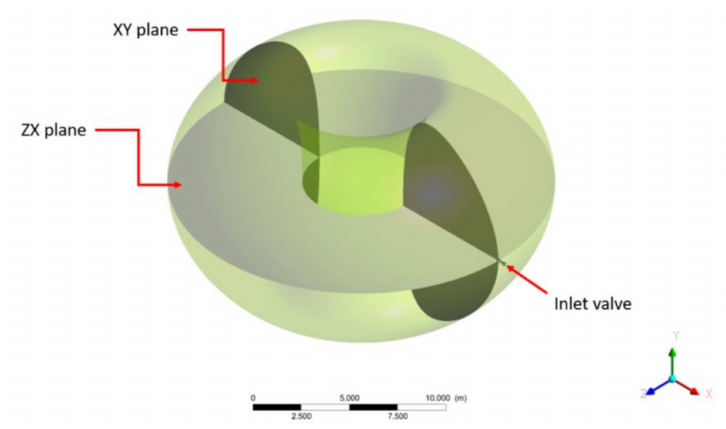
Figure 2. Domain geometry, inlet valve and planes of analyses (zx and